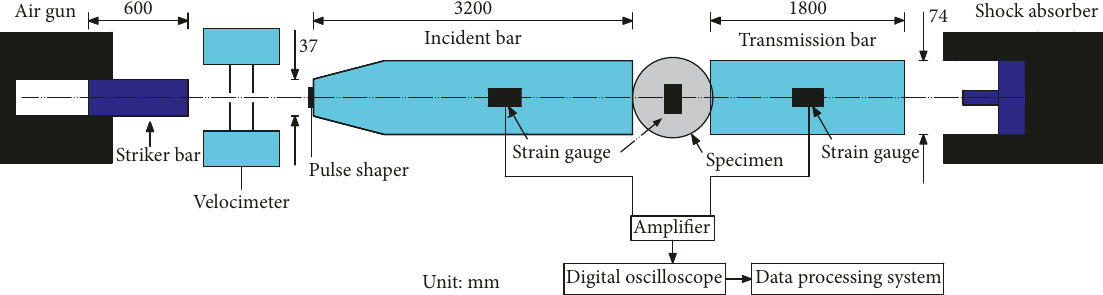
Figure 7: Dynamic Brazilian disc test setup.